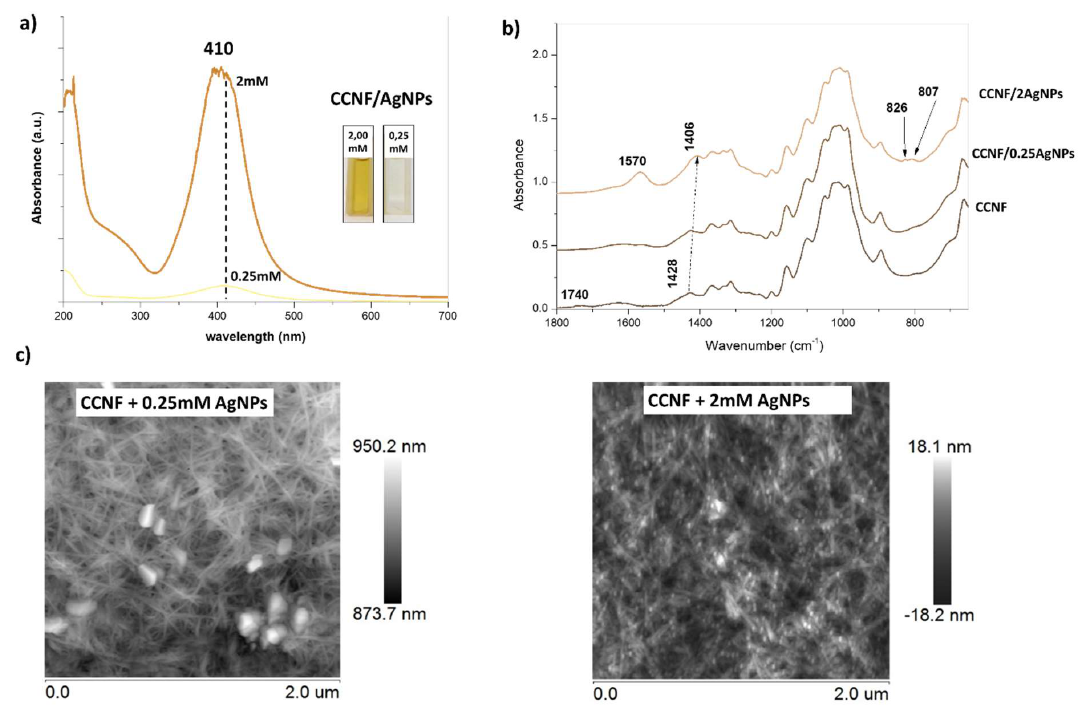
Figure 1. ( a ) UV-Vis spectra of CCNF/ AgNPs 0.25 and 2 mM dispersions in water. ( b ) FTIR spectra of CCNF, CCNF/AgNPs 0.25 mM and 2 mM in the range 1800–650 cm −1 . ( c ) AFM images of CCNF/AgNPs 0.25 and 2 mM with visible silver nanoparticles attached to nanocellulose.